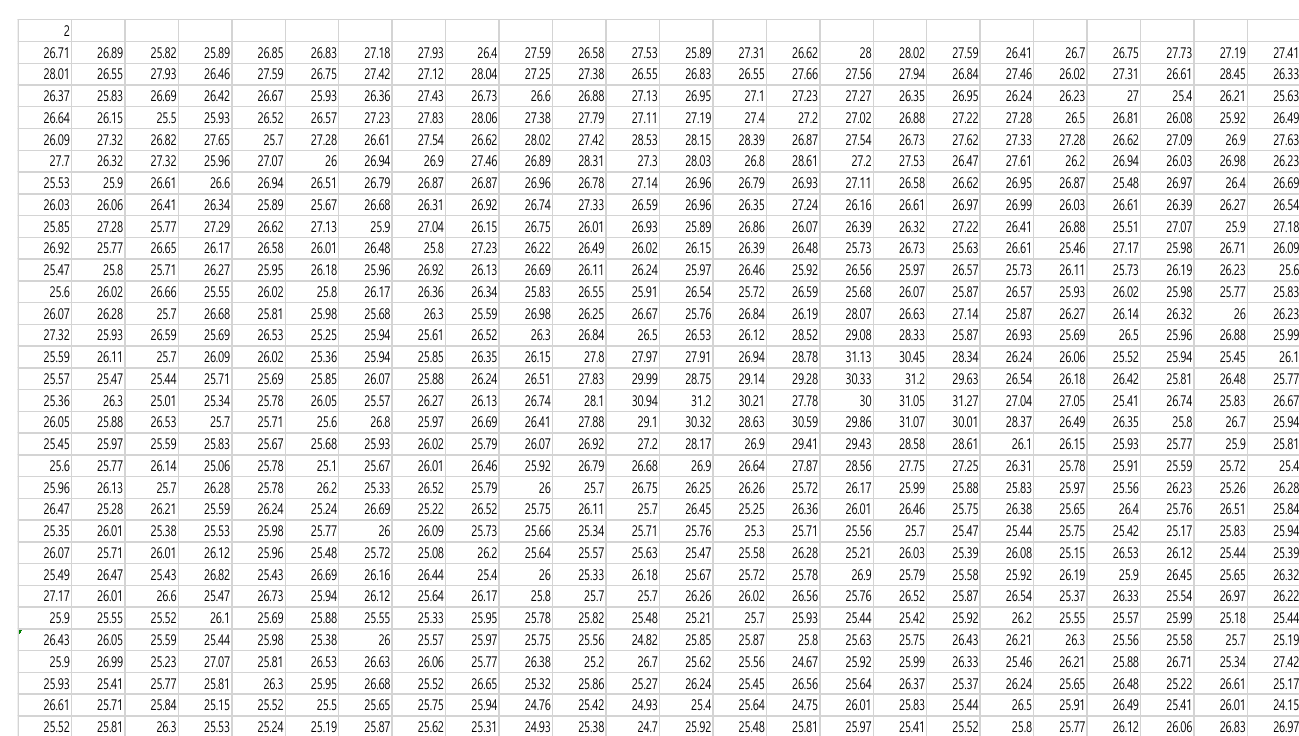
Figure 8. Thermal image.